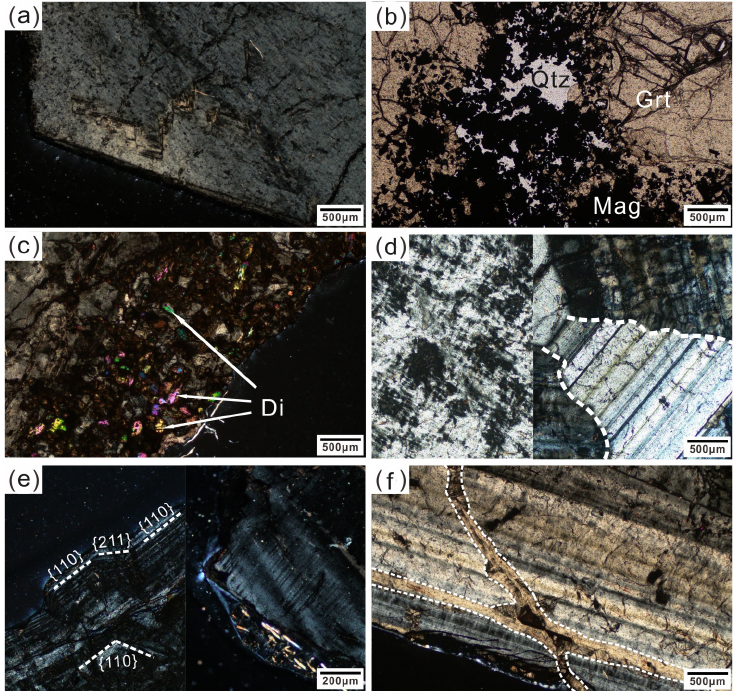
Figure 3. Representative photomicrographs under crossed polarized light XPL and under plane polarized light PPL. ( a ) The microscopic rhombic growth pits on the rhombic dodecahedron face (XPL); ( b ) Isotropic and subhedral stage I garnet and associated minerals, magnetite and quartz (PPL); ( c ) Anisotropic stage II garnet with granular diopside (XPL); ( d ) Abnormal extinction, such as patch extinction (left), sector extinction, and oscillatory zonation (right) (XPL). Note the irregular boundary (dashed line); ( e ) The {211} faces appear on the outer edge of the {110} faces (left) and the lamellae perpendicular to crystal faces (right) (XPL); ( f ) Stage III vein garnet (dashed line) cut through stage II garnet (XPL). Mineral abbreviations: Di—diopside; Mag—magnetite; Grt—garnet; Qtz—quartz.